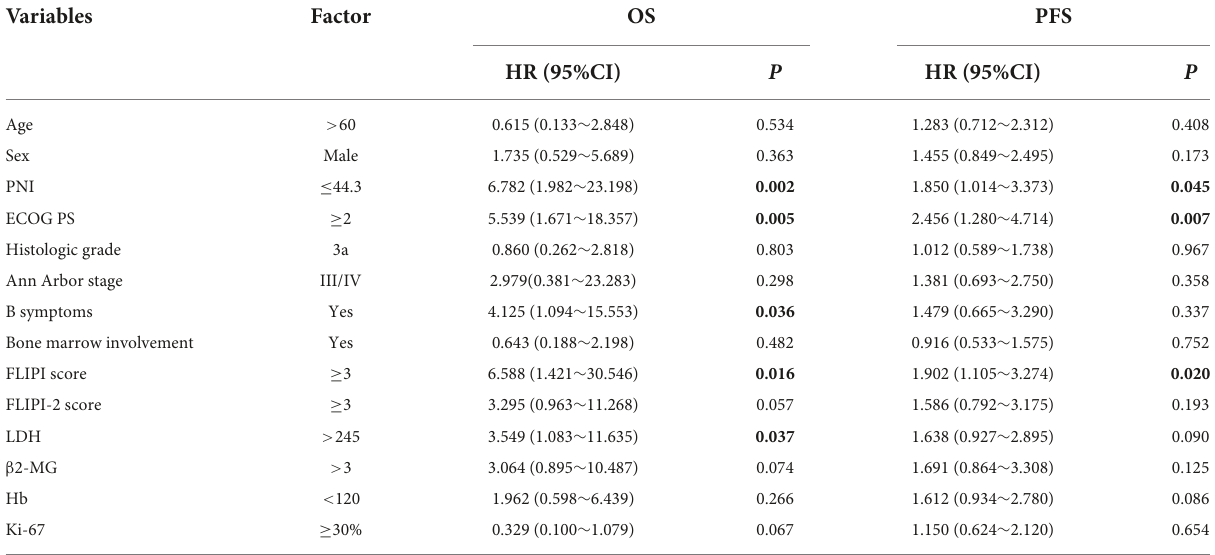
TABLE 3 Univariate analysis of patients with